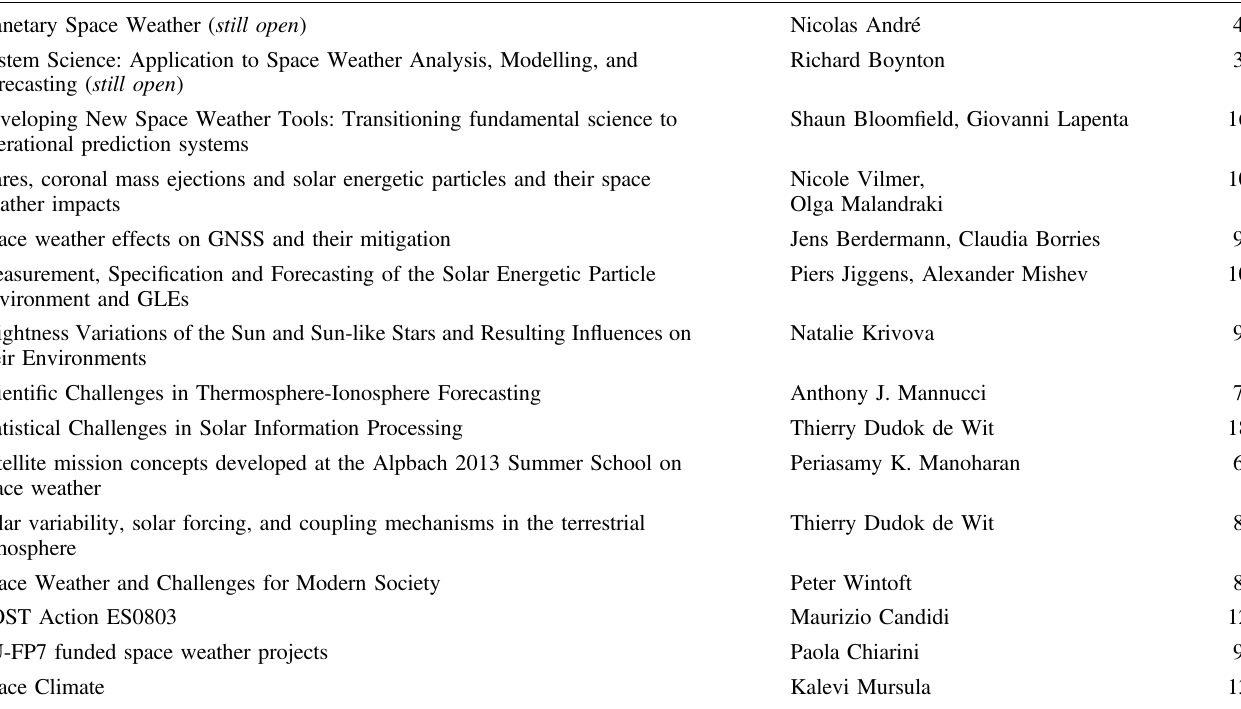
Table 1. Overview of all Topical